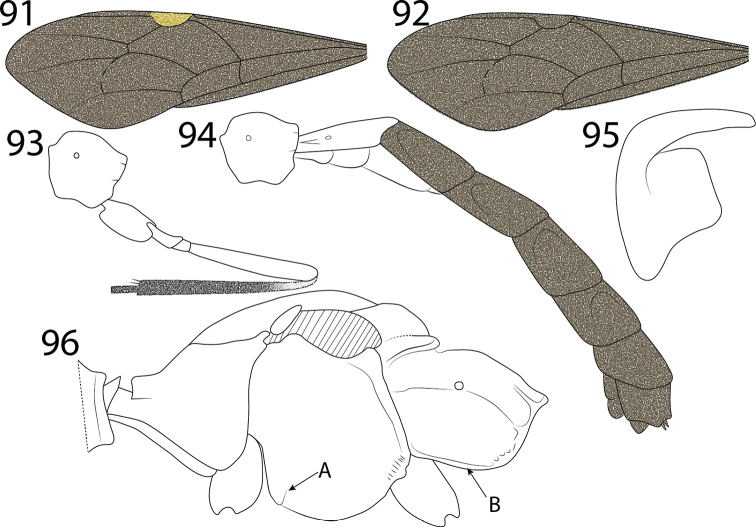
Hymenoepimecis spp. 91, 92 fore wing, showing colour pattern. (91) H.
veranii (92) H.
argyraphaga93H.
robertsae, propodeum and hind leg, showing colour pattern, lateral view 94H.
heteropus, propodeum and metasoma, showing colour pattern, lateral view 95H.
amazonensis (female), tarsal claw, lateral view 96H.
argyraphaga, mesosoma, lateral view: Arrow “A” shows epicnemial carina and arrow “B” shows submetapleural carina.